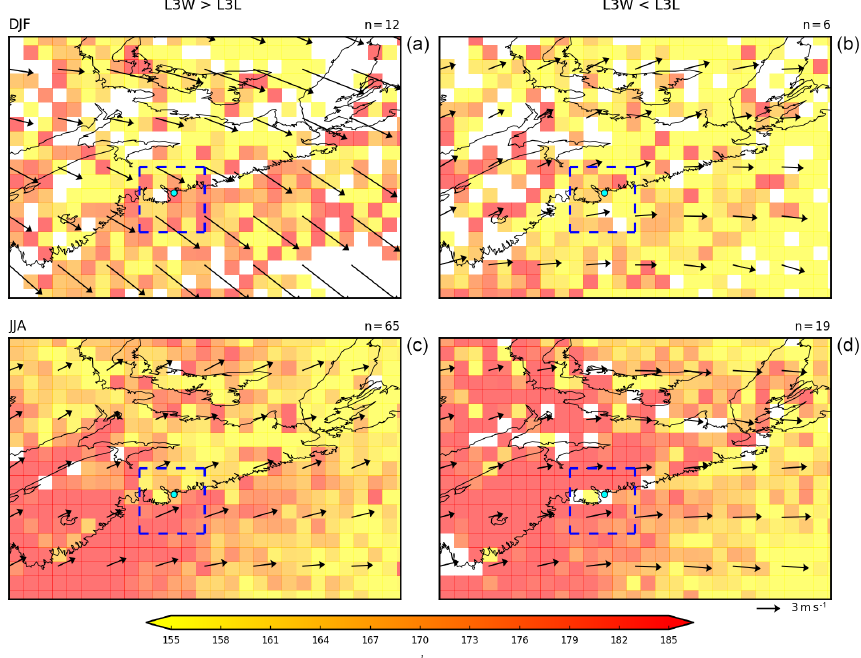
Figure 7. Mean ERA-Interim 10m winds (vectors) and MOPITT L2 (these maps were created from L2 data that were interpolated to a regular 0 . 25 ◦ × 0 . 25 ◦ grid for ease of plotting) VMR at the surface profile level (shading) for days when retrieved surface level VMRs in L3W are greater than in L3L (L3W > L3L) and days when they are less (L3W < L3L). (a, b) DJF; (c, d) JJA. Blue dashed square represents the outline of the L3 grid box that contains